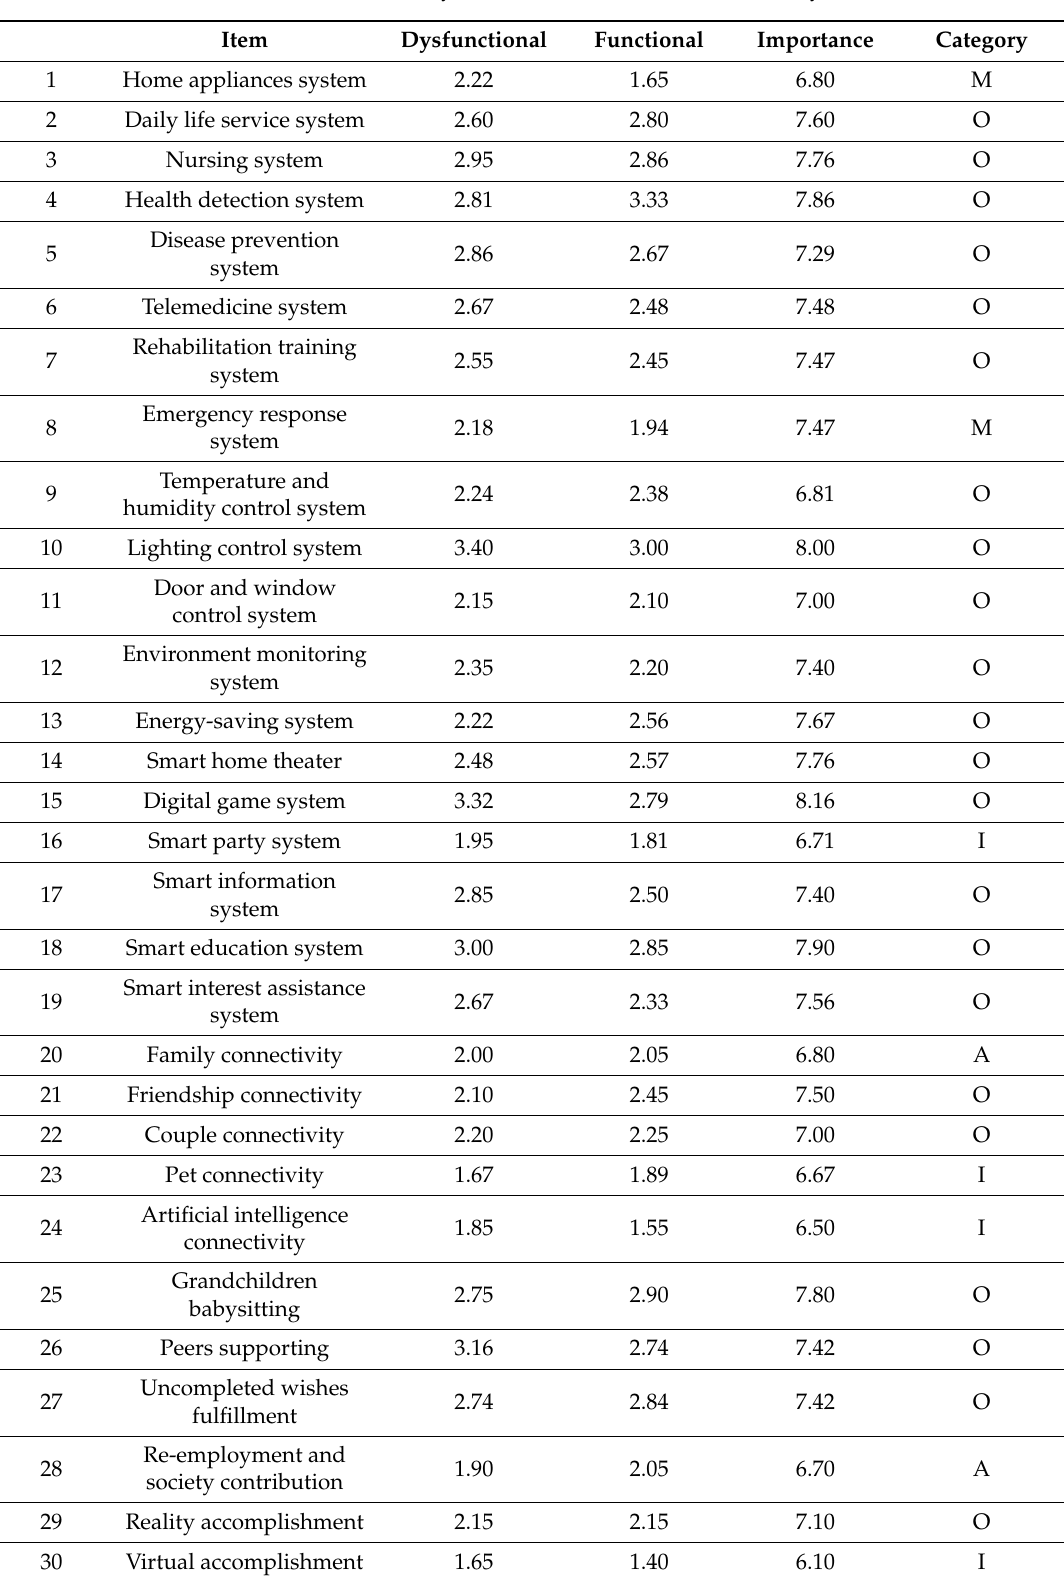
Table 7. Continuous Analysis of Attribute for smart home